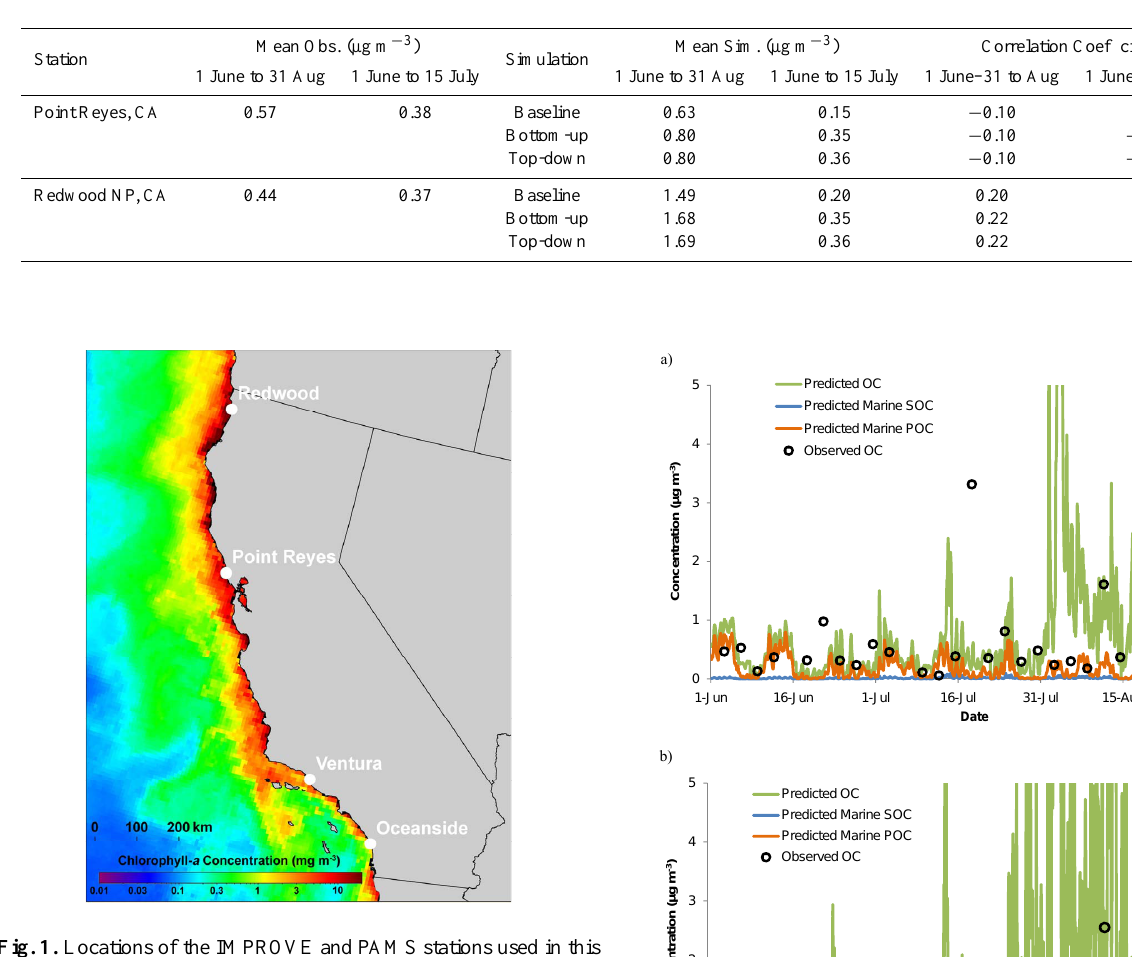
Fig. 1. Locations of the IMPROVE and PAMS stations used in this study and the seasonally-averaged chlorophyll- a concentrations for the summer of 2005.